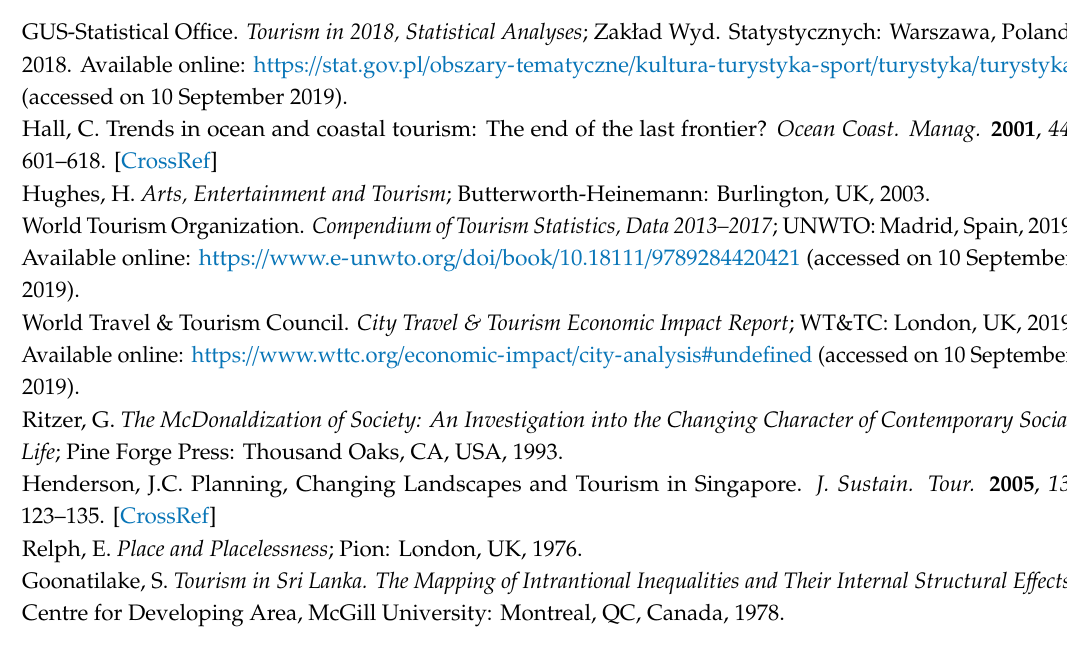
Figure S1—Stage I: Formation—Elite resort, Figure S2—Stage II: Regionalism—National resort, Figure S3—Stage III: Socialization—A resort for working masses, Figure S4—Stage IV: Pluralism—Egalitarian